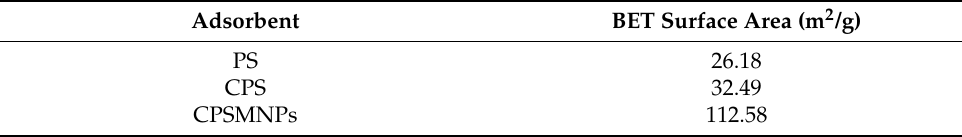
Table 2. BET surface area analysis of PS, CPS, and